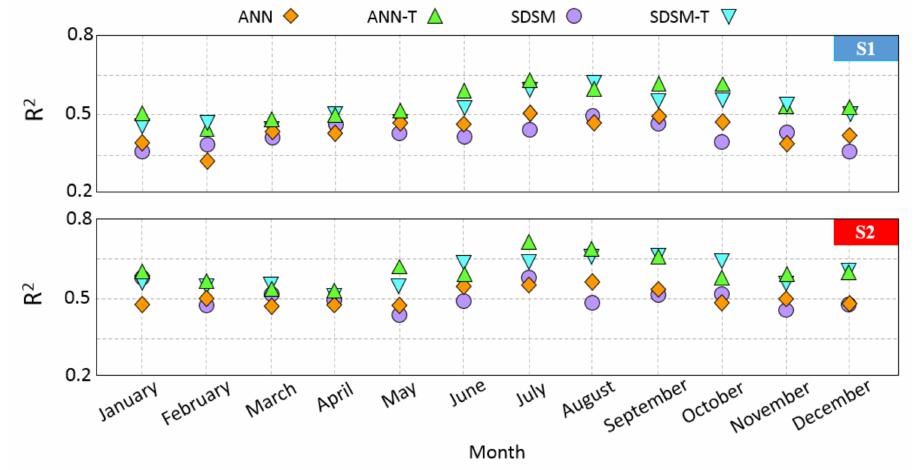
Figure 10. Determination coefficient between observations and modeled daily